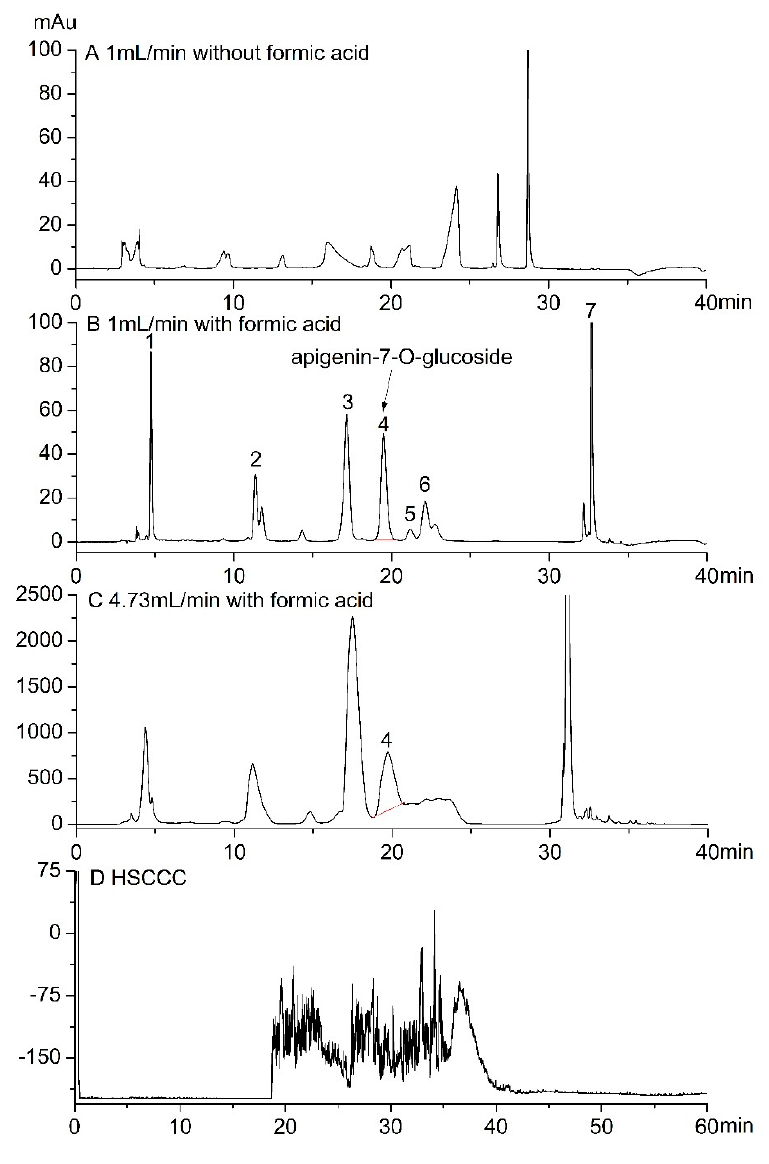
Analysis and purification of apigenin-7-O-glucoside from C. morifolium ‘Huangju’. 1: chlorogenic acid, 2: luteolin-7-O-glucoside, 3: 3,5-dicaffeoylquinic acid, 4: apigenin-7-O-glucoside, 5: apigenin-7-O-glucuronide, 6: luteolin-7-O-6”-malonylglucoside, 7: apigenin. ( A ) 10 µ L of 10 mg/mL chrysanthemum extract at a flow rate of 1 mL/min without formic acid. ( B ) 20 µ L of 10 mg/mL chrysanthemum extract at a flow rate of 1 mL/min with formic acid. ( C ) 400 µ L of 100 mg/mL chrysanthemum extract at a flow rate of 4.73 mL/min with formic acid with preparative HPLC. ( D ) 400 μ L of 100 mg/mL chrysanthemum extract with HSCCC.